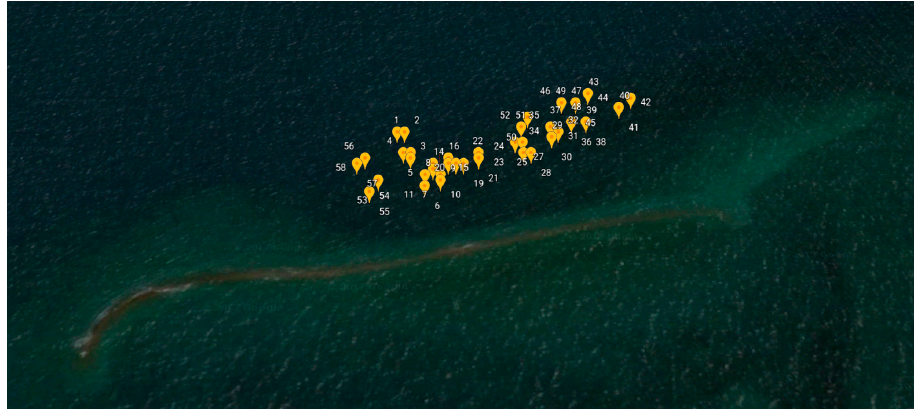
Figure 13. Numbered in-water survey GPS coordinates at Pandora Reef shown through Google Earth.